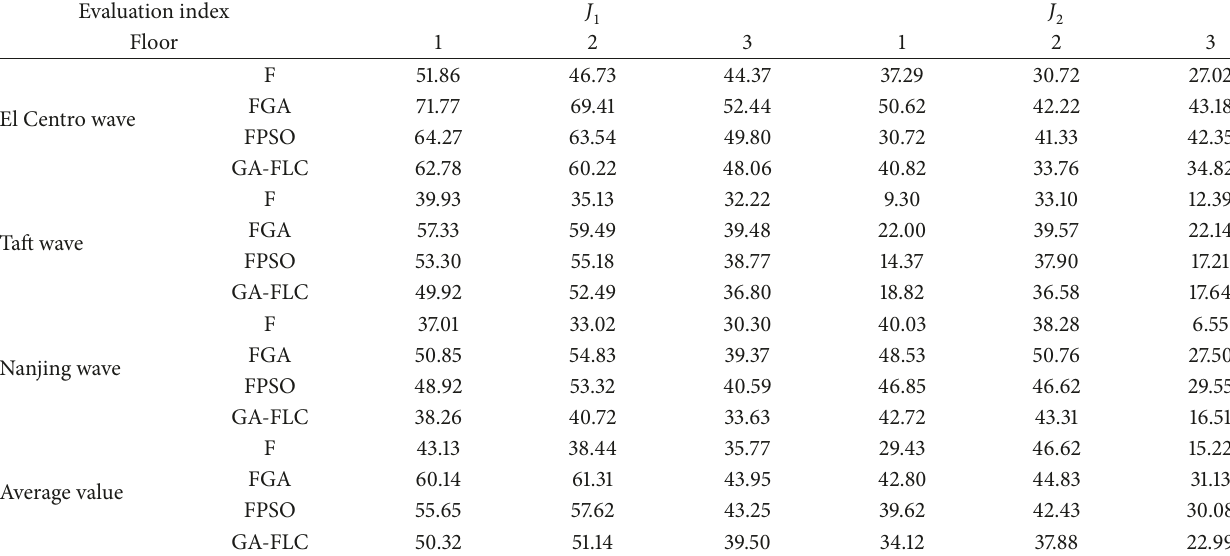
Table 7: Each layer’s peak displacement and acceleration control effect under the three types of seismic